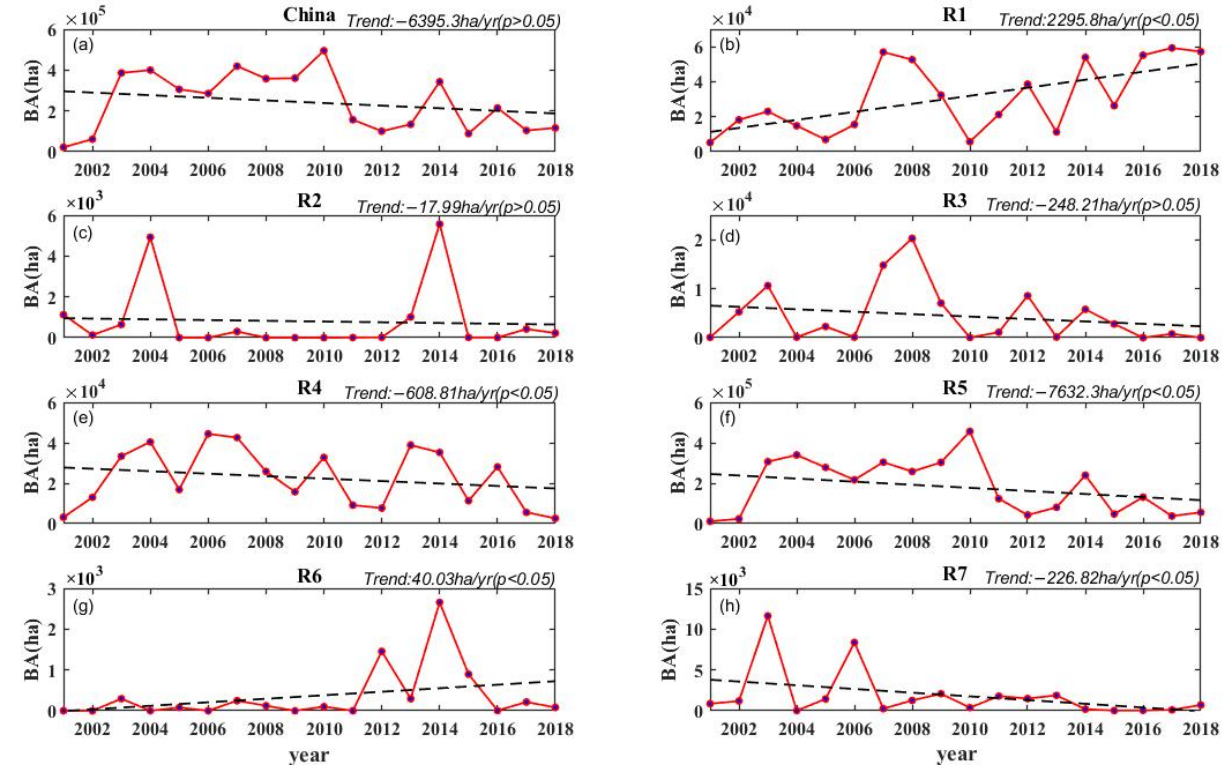
Figure 8. The trends of the BA in China and in R1–R7 in winter.